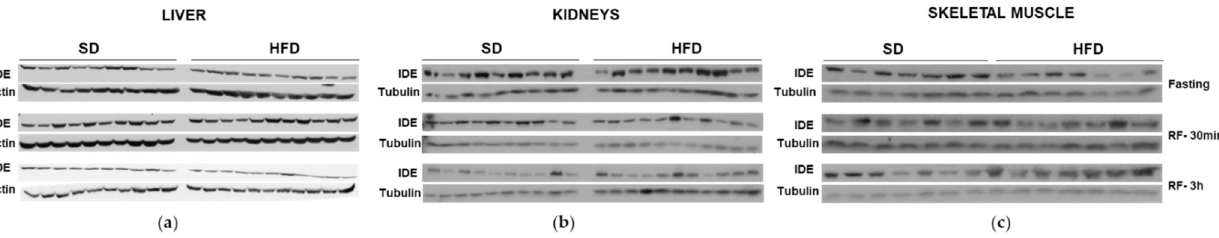
Figure A3. Effects of feeding conditions on levels exons 15a and 15b of mouse Ide . ( a ) Levels of 15a Ide mRNA in the liver. ( b ) Levels of 15a Ide mRNA in the liver. ( c ) Ratio 15a/15b. Data are the means ± SEM. N = 9–10 mice per condition. * p < 0.05 vs. fasting by ANOVA. $ p < 0.05 vs. SD by ANOVA. ( d ) Alignment of forward and reverse primers to mouse Ide gene sequence (NC_000085.7:c37341664-37246140).